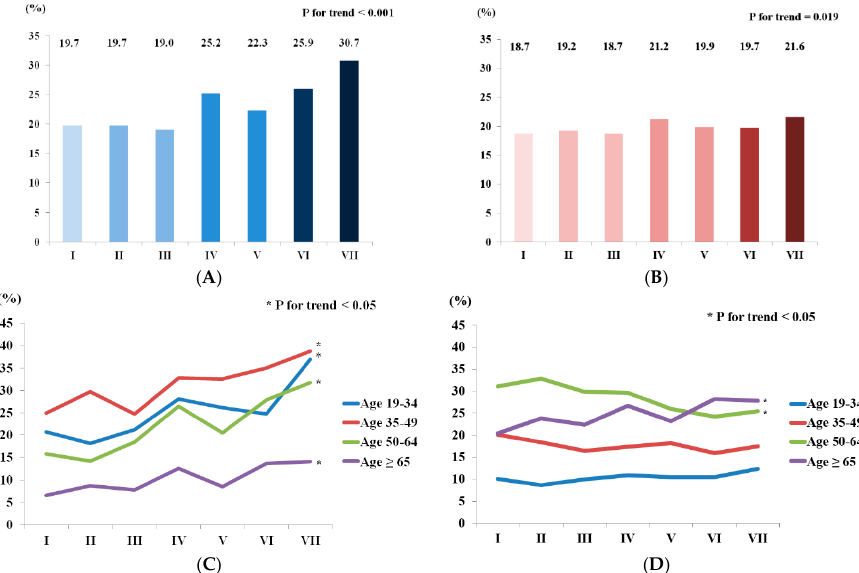
Figure 1. Trends in the prevalence of NAFLD in Korean men and women, KNHANES waves I-VII. ( A ) Prevalence of NAFLD in Korean men; ( B ) prevalence of NAFLD in Korean women; ( C ) prevalence of NAFLD in Korean men according to age group; ( D ) prevalence of NALFD in Korean women according to age group. NAFLD, non-alcoholic fatty liver disease; KNHANES, Korea National Health and Nutrition Examination Survey.